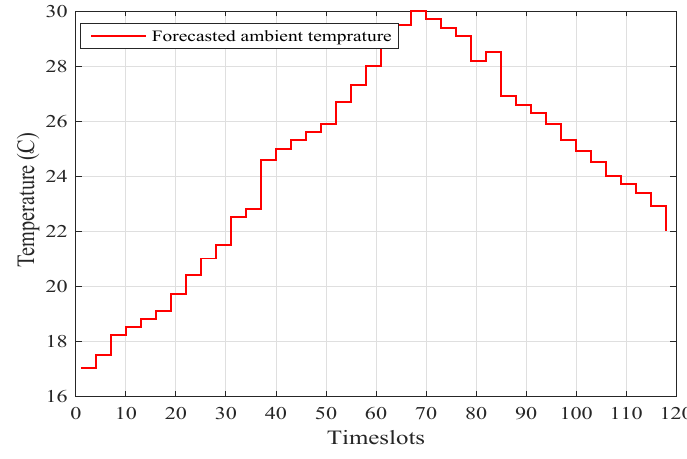
Figure 10. Forecasted temperature profile.